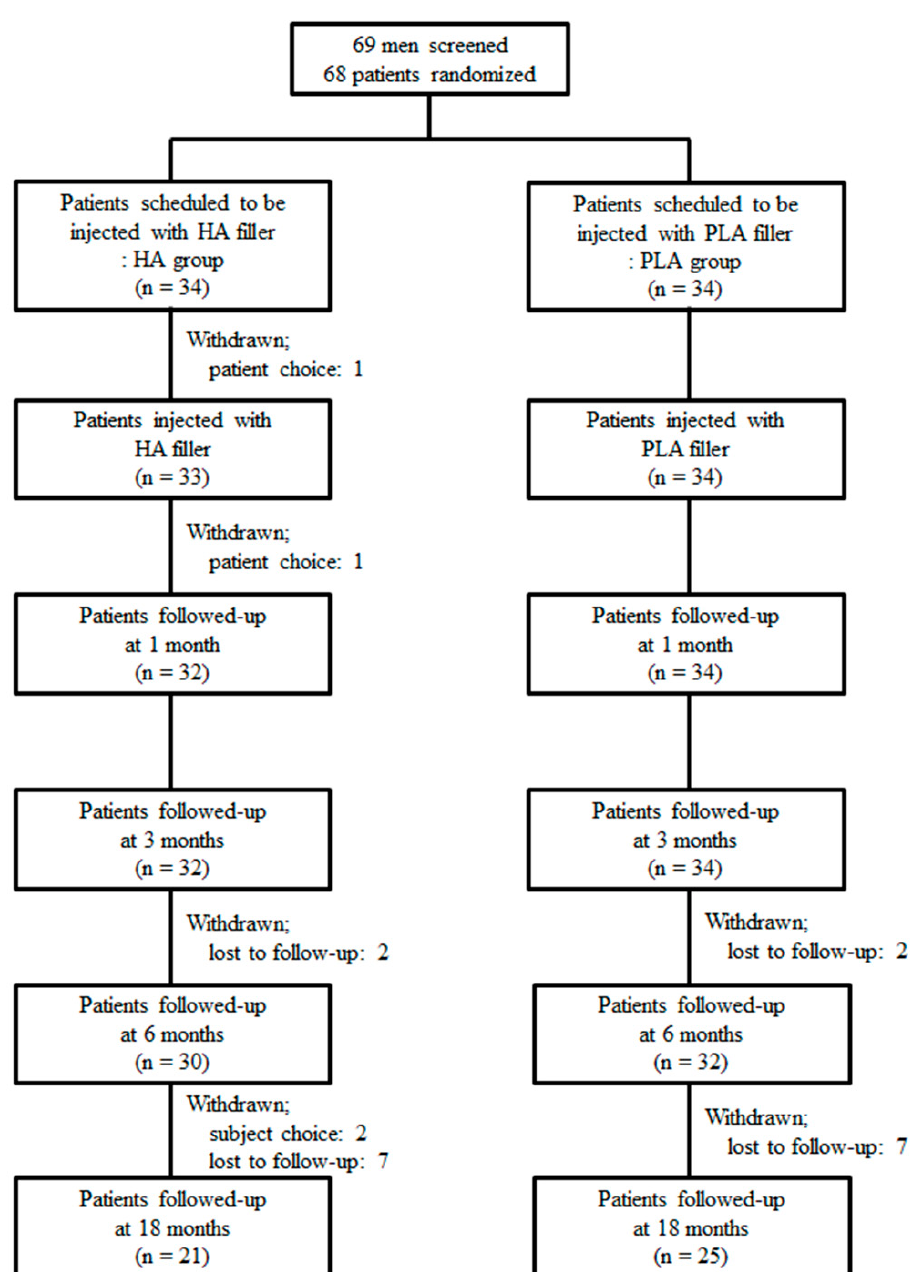
Figure 1. Patients distribution and information. HA, hyaluronic acid; PLA, polylactic acid.